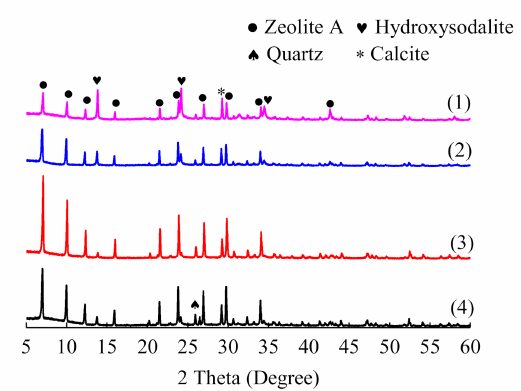
Figure 4. XRD of zeolite A synthesized at di ff erent hydrothermal reaction temperatures.